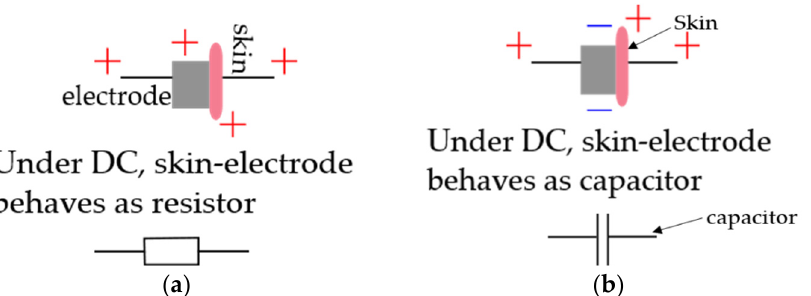
Figure 2. Schematic representation of: ( a ) ideal non-polarizing electrode; ( b ) ideal polarizing elec- trode.